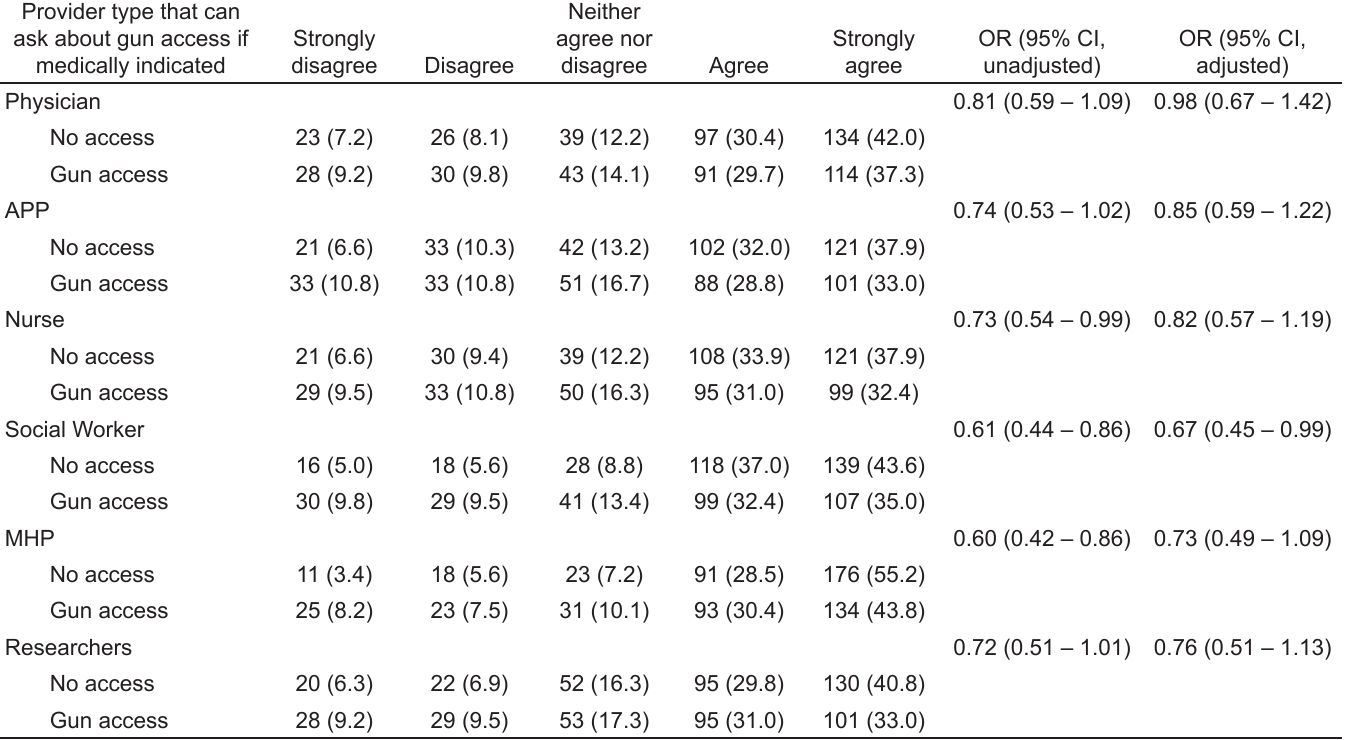
Table 3. Opinion of patients regarding provider type initiating firearm safety discussions, gun access vs no gun access.